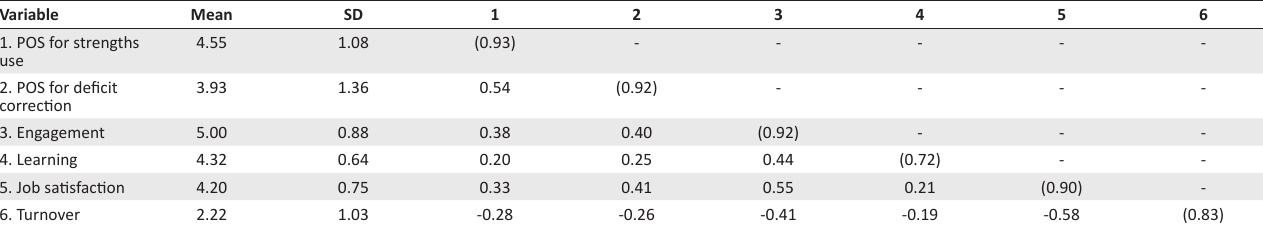
TABLE 2: Correlation matrix ( r ) of the latent